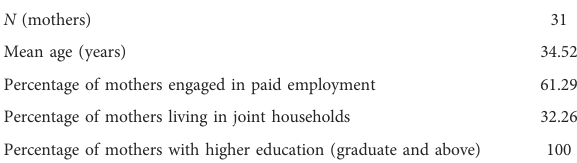
TABLE 2 Statistical summary of sociodemographic information of mothers